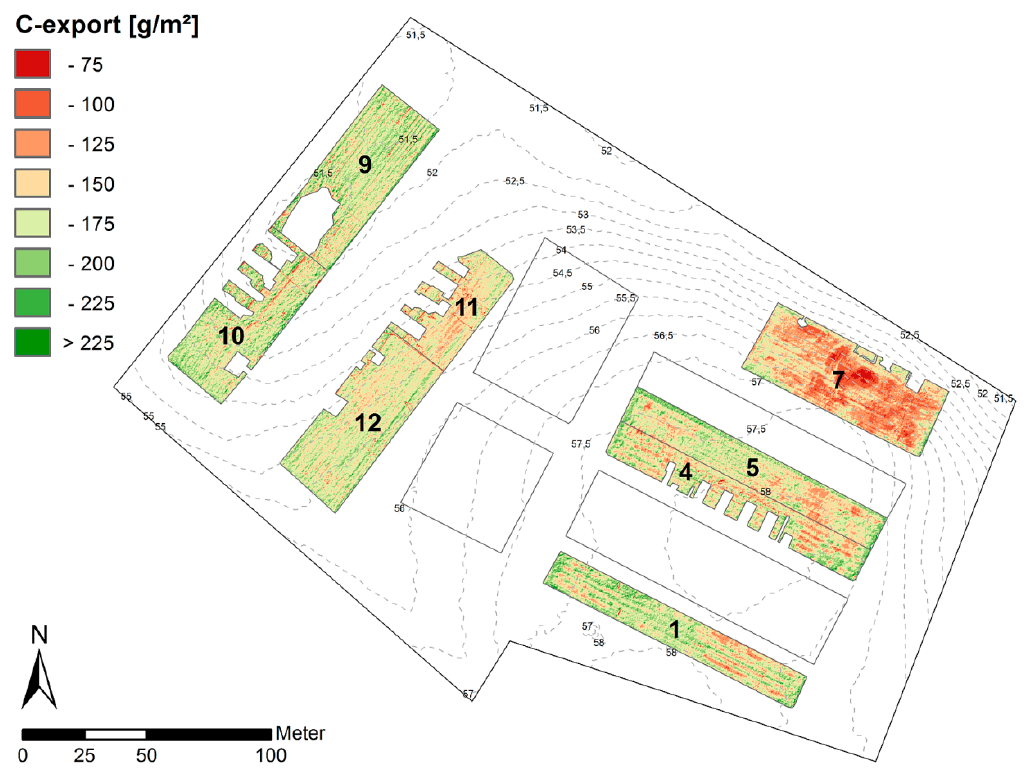
Figure 18. Spatial distribution of total exported carbon by harvest within the eight plots of lucerne at the CarboZALF experimental area.